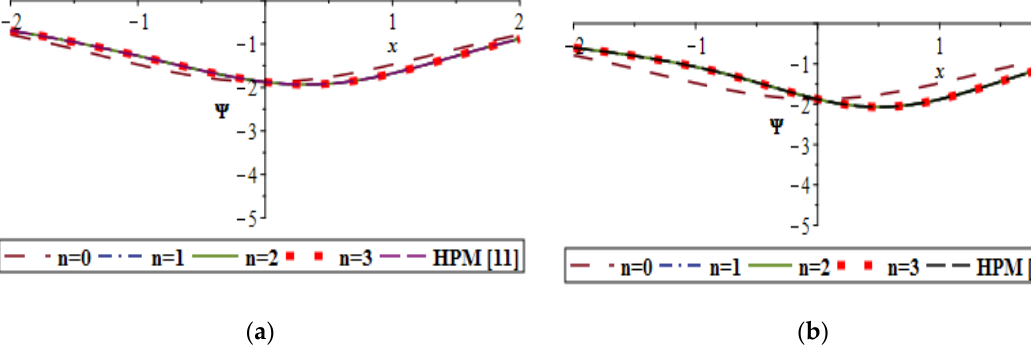
Figure 8. Comparison plots of ψ FRDTM and ψ HPM [11] of Degasperis–Procesi (DP) equation for − 10 ≤ x ≤ 10. ( a ) t = 0.05, α = 1; ( b ) t = 0.1, α = 1.